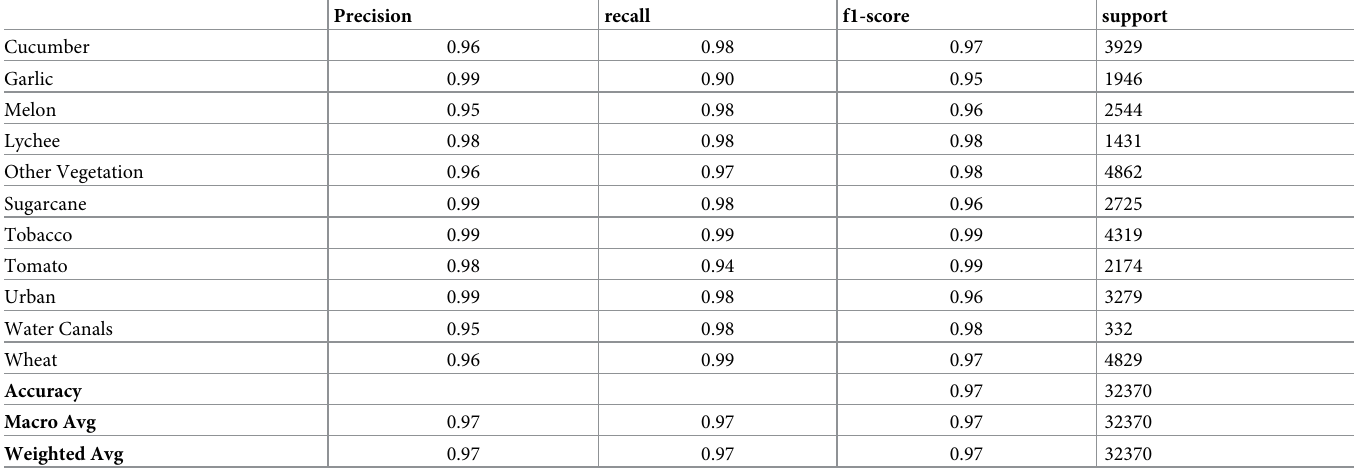
Table 2. Classification report Planet